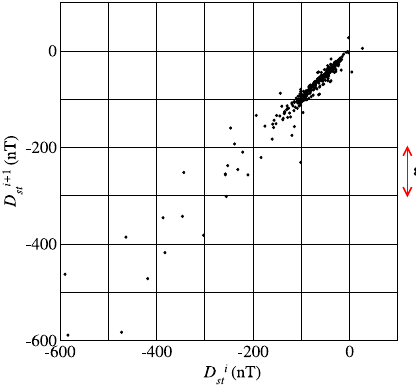
Figure 1. Scatter diagram for Dst time series, using data from 6 to 20 March 1989, containing a large geomagnetic storm. (Taken from Domínguez et al., 2014.)